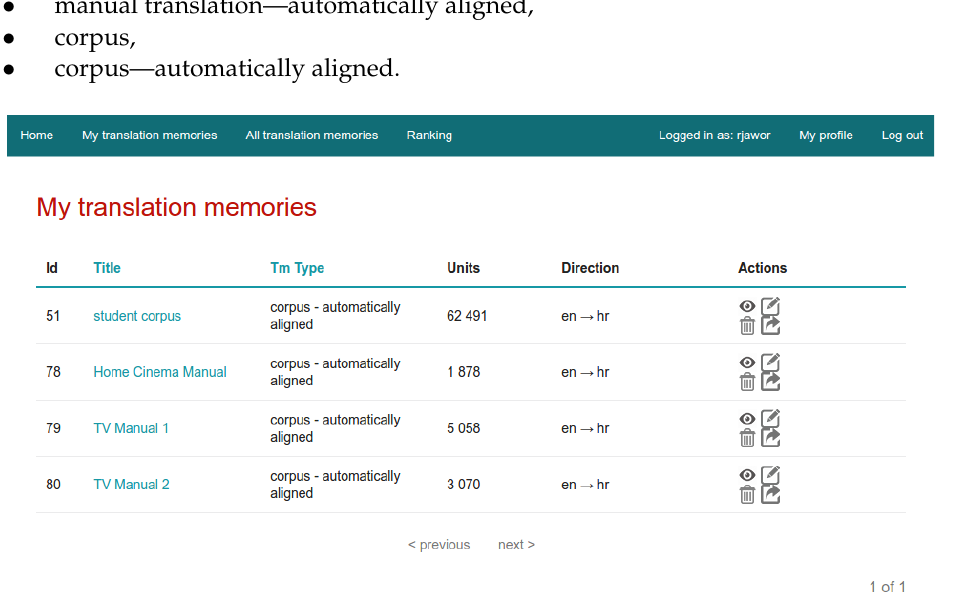
Figure 1. The main window of the system—a list of uploaded translation memories.